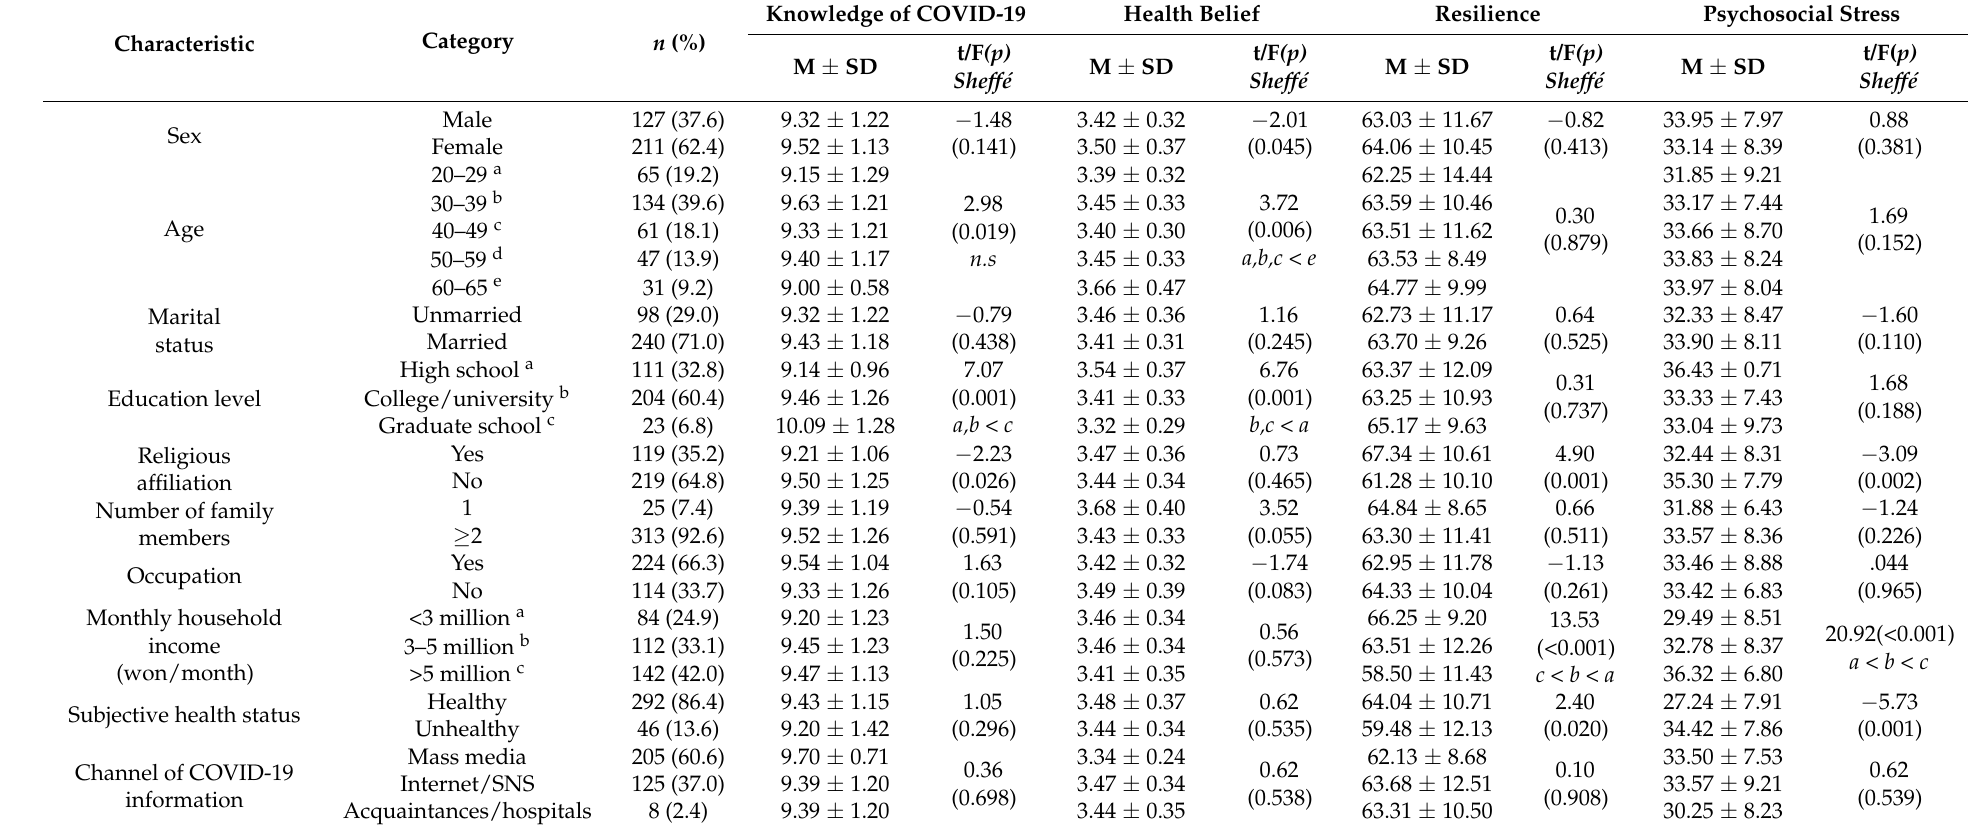
Table 2. Differences among participants’ scores for knowledge of COVID-19, health belief, resilience, and psychosocial stress by sociodemographic characteristics.